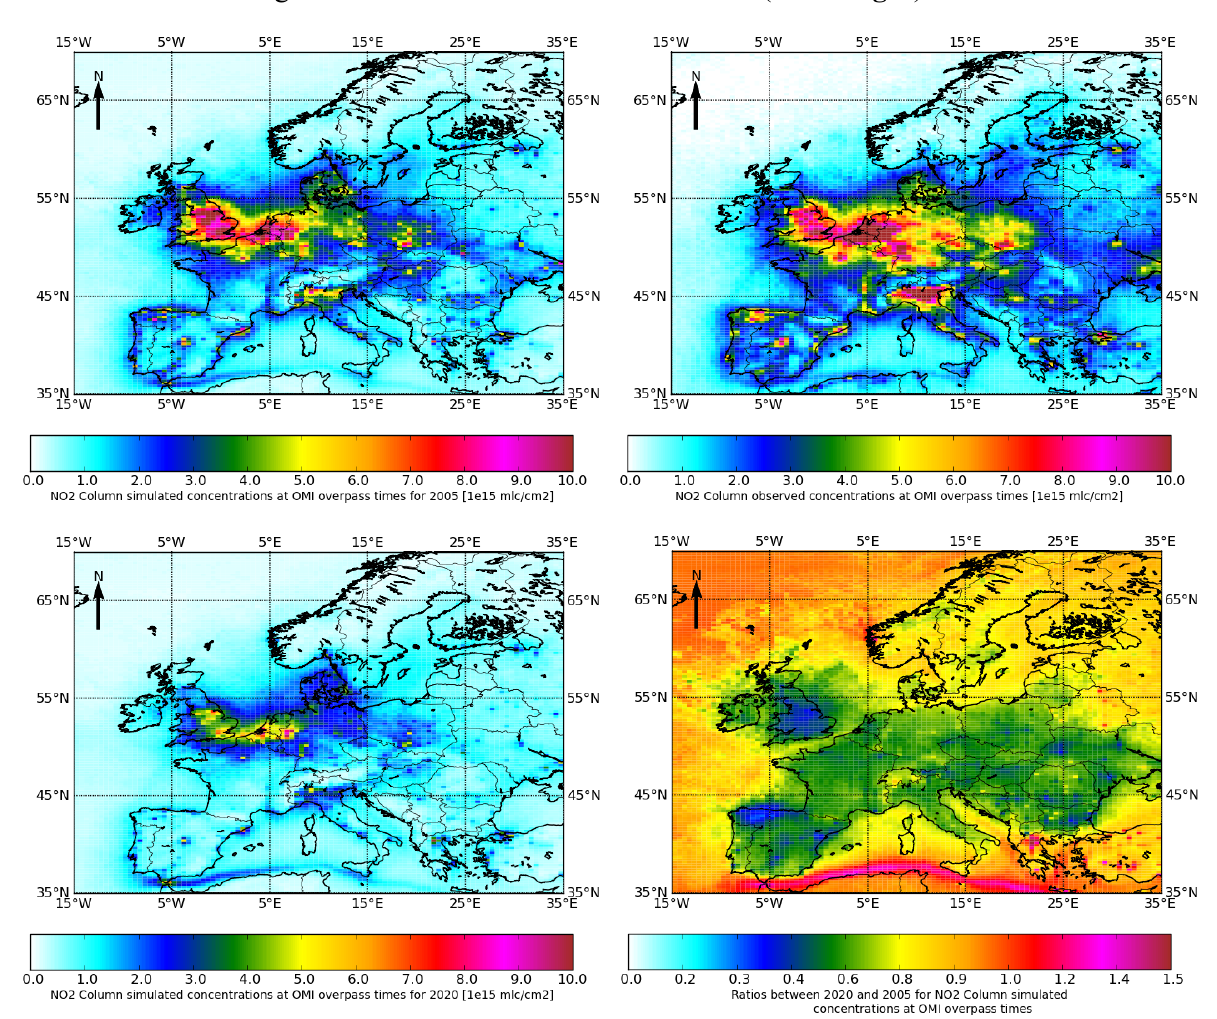
Figure 2. Modeled ( upper left ) and retrieved ( upper right ) annual mean NO (10 15 molecules (mlc)·cm − 2 ) across Europe for 2005, as well as the annual mean NO column (10 15 mlc·cm − 2 ) across Europe modeled for 2020 ( lower left ), and the ratio between the average columns for 2020 and those for 2005 ( lower right